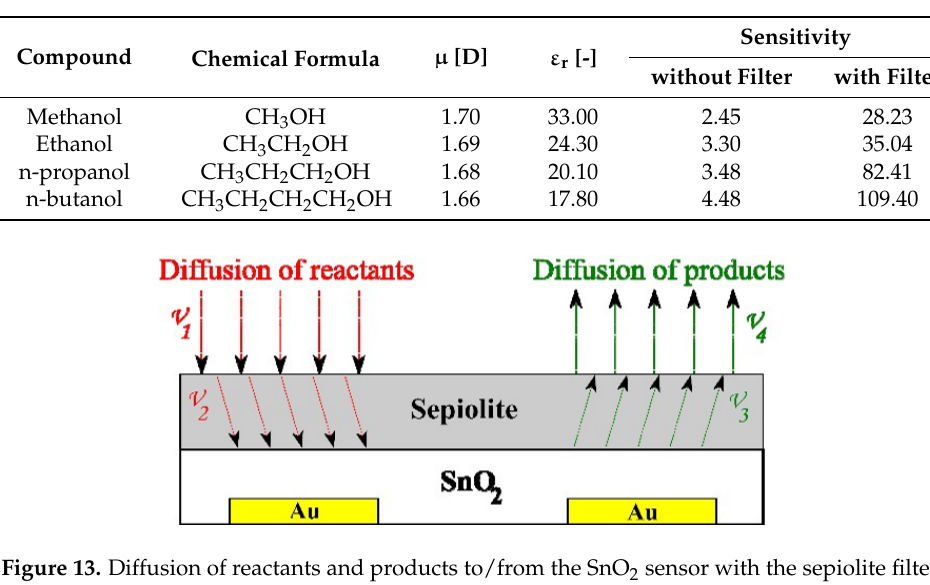
Table 1. Chemical formula, dipole moment, relative electric permittivity of the determined volatile organic compounds and sensitivity in the presence of 2 ppm of these compounds.